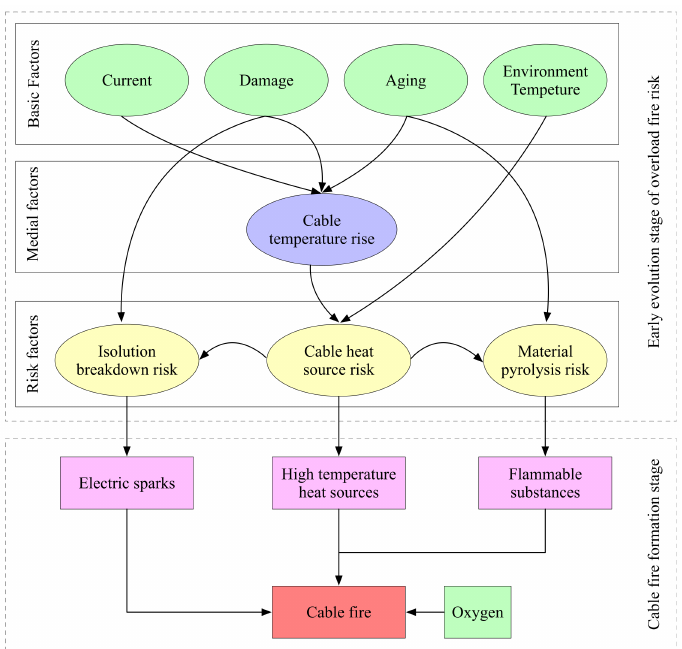
Figure 1. Risk transmission paths of overload-induced cable